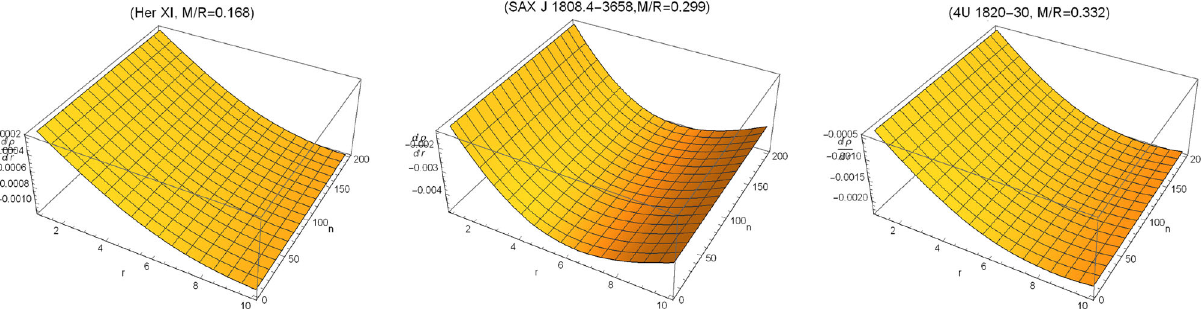
Fig. 6 Behavior of d ρ with radial coordinate r (km) and model parameter n d r